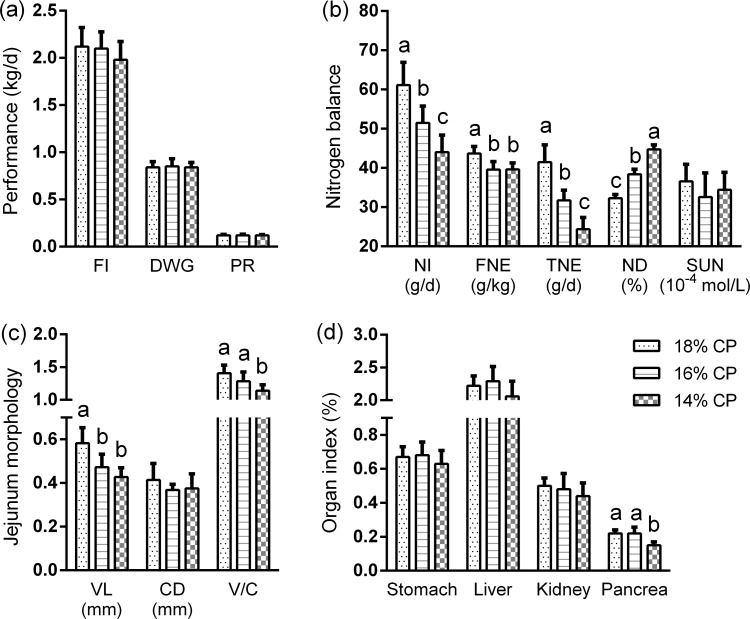
Effects of dietary protein restriction on performance (a), nitrogen balance (b), jejunum morphology (c), and organ index (d) of growing pigs (n = 6). 14% CP, 16% CP, and 18% CP represent experimental diets containing 14, 16, and 18% crude protein respectively. Organ index represents the relative weights of organs. Means without a common letters differ significantly (P < 0.05). FI, food intake; DWG, daily weight gain; PR, protein retention; NI, nitrogen intake; FNE, fecal nitrogen excretion; TNE, total nitrogen excretion; ND, nitrogen digestibility; SUN, serum urea nitrogen; VL, villus length; CD, crypt depth; V/C, the ratio of villus length to crypt depth.